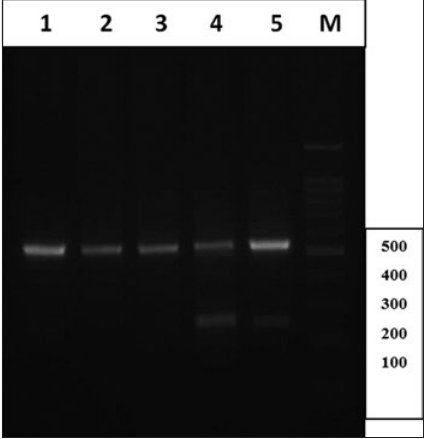
Figure-1: Electrophoresis of polymerase chain reaction products of the nad1 gene of E. granulosus using DNA extracted by different methods. Lane 1: Samples extracted by the commercial kit in two-step incubation procedure (initially at 60°C for 2 h and then overnight at 37°C); Lane 2: Samples extracted by the commercial kit in one step at 60°C for 2 h; Lane 3: Samples extracted by the commercial kit in one step at 37°C with overnight incubation; Lane 4: Samples extracted manually, using phenol/chloroform and freeze/thawing; and Lane 5: Samples extracted by Triton X-100; M: Molecular weight marker.